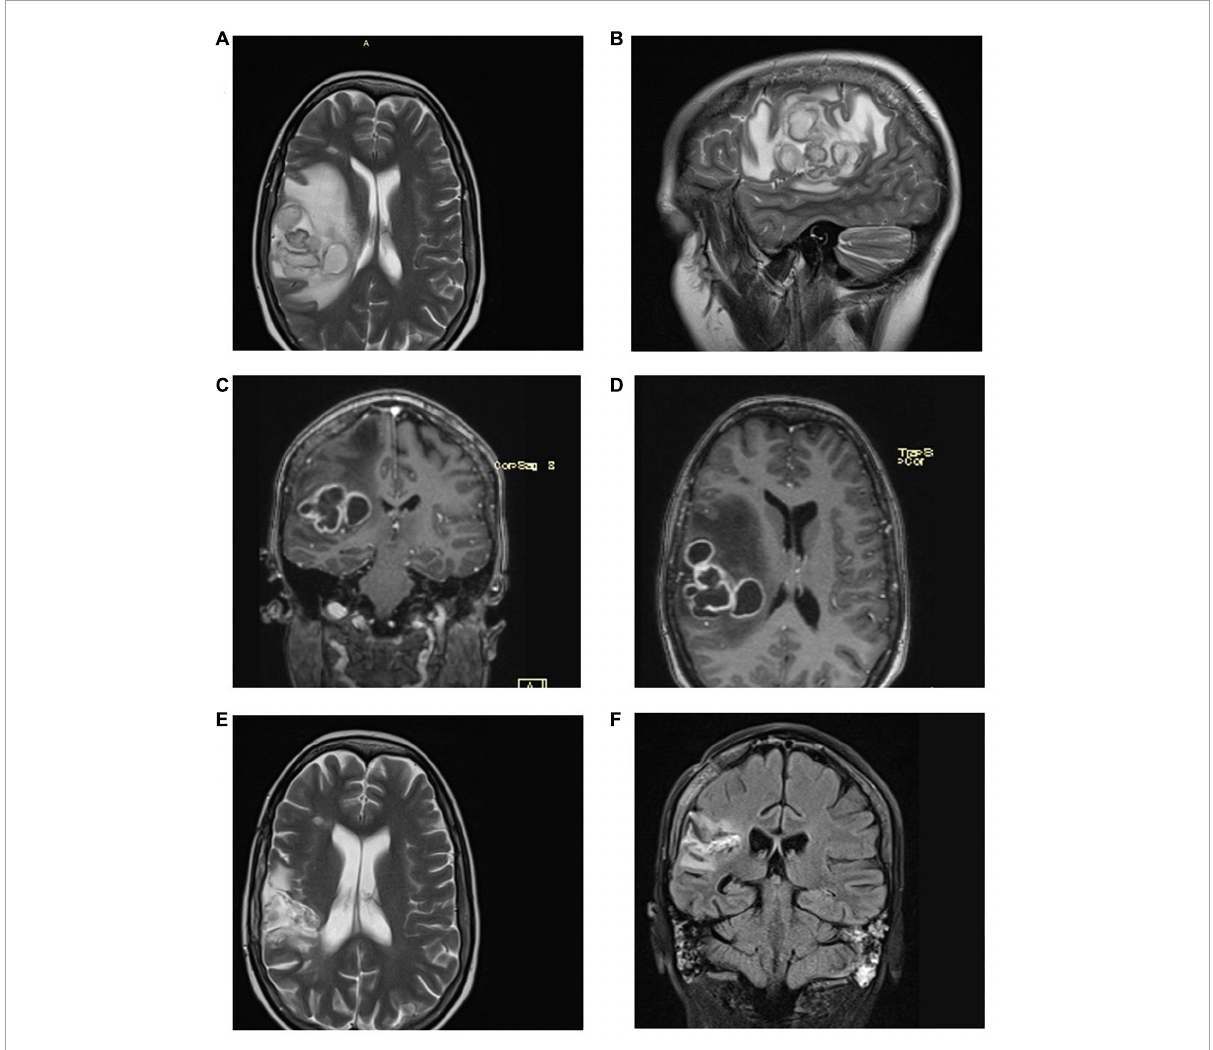
FIGURE1 (A,B) Axial and sagittal plane of the brain MRI on June 15 shows a right parietal-temporal lesion with huge perilesional edema, compression of the right lateral ventricle, and mediosagittal shift; (C,D) Contrast-enhanced ring lesions on the coronal and axial plane with perilesional edema. (E,F) Postoperative MRI on September 1 with postoperative sequela, abscess regression, and perifocal